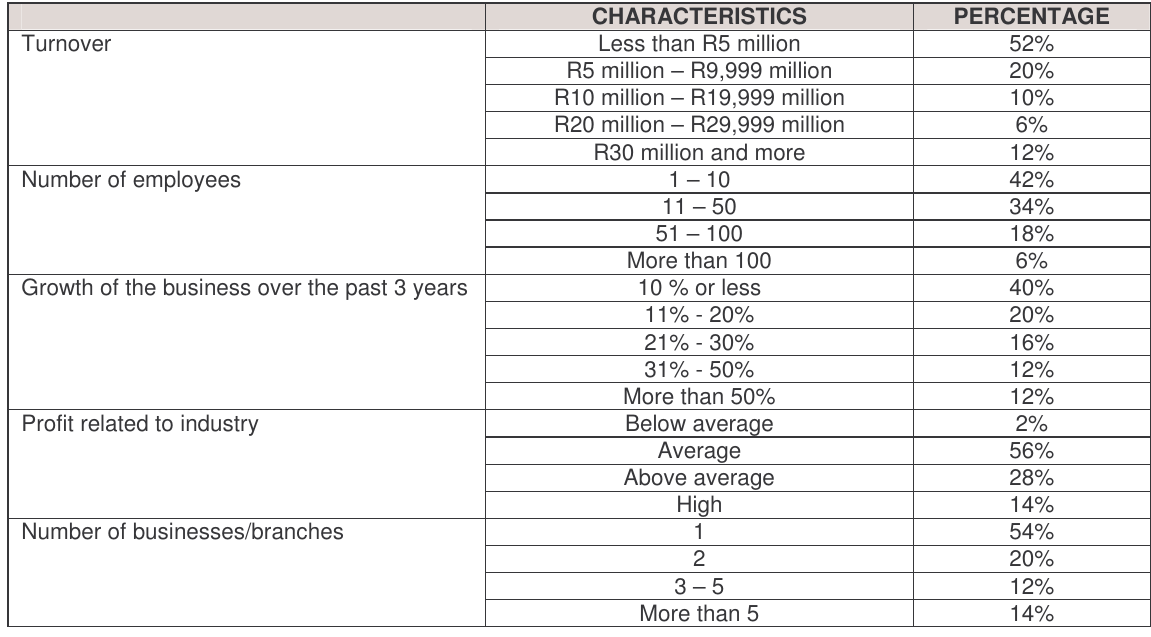
Table 3: Characteristics of the businesses of successful, established entrepreneurs